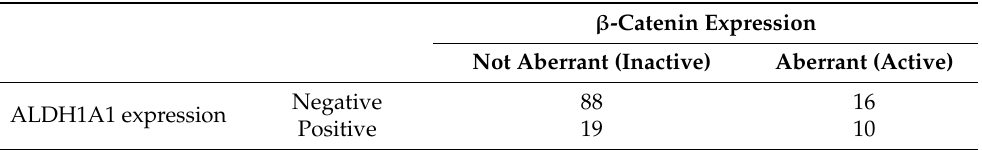
Figure 5. Expression of β -catenin and CSC markers in muscle-invasive bladder carcinomas. β - catenin, ALDH1A1, and Sox-2 immunostains of two representative cases of muscle-invasive bladder carcinomas are shown. Case 1 shows non-aberrant (membrane staining) β -catenin and absence of ALDH1A1 and Sox-2. Case 2 shows aberrant (loss of membrane staining) β -catenin and the presence of ALDH1A1 and Sox-2. Bar, 50 µM. Table 1. Contingency table with the distribution of β -catenin and ALDH1A1 immunostains in 133 cases of muscle-invasive bladder carcinomas.